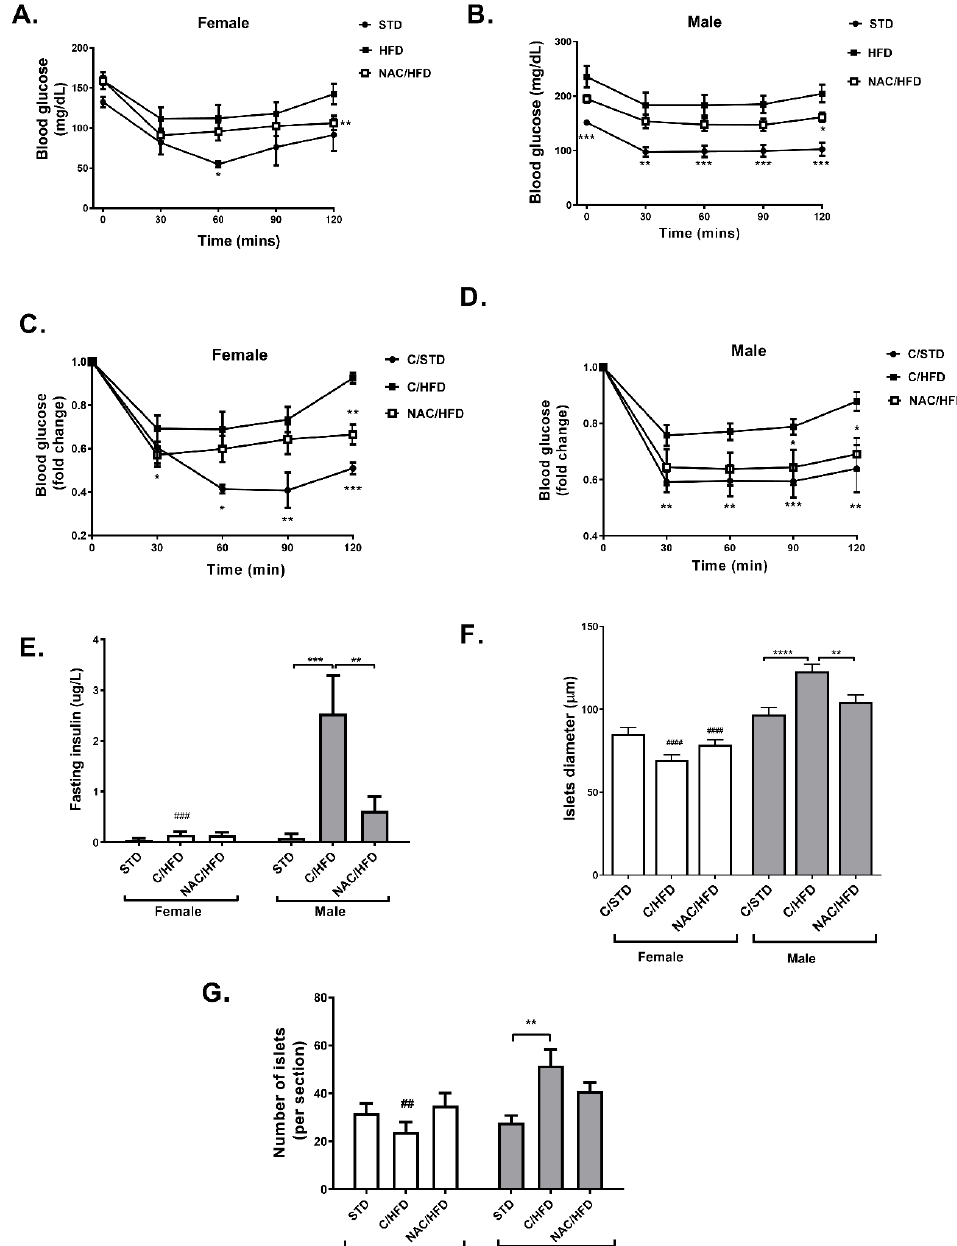
Figure 2. NAC improved insulin sensitivity in HFD-fed offspring of NAC-treated male mice.